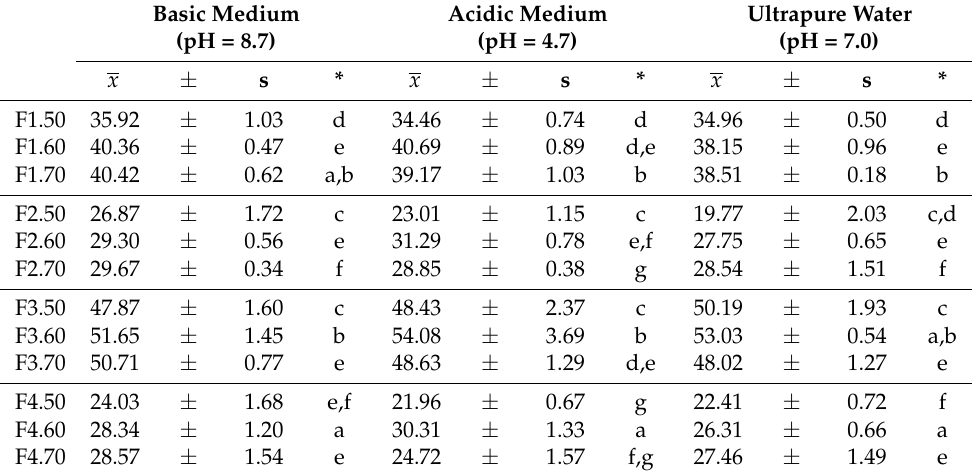
Table 2. Solubility of prepared edible films in different media